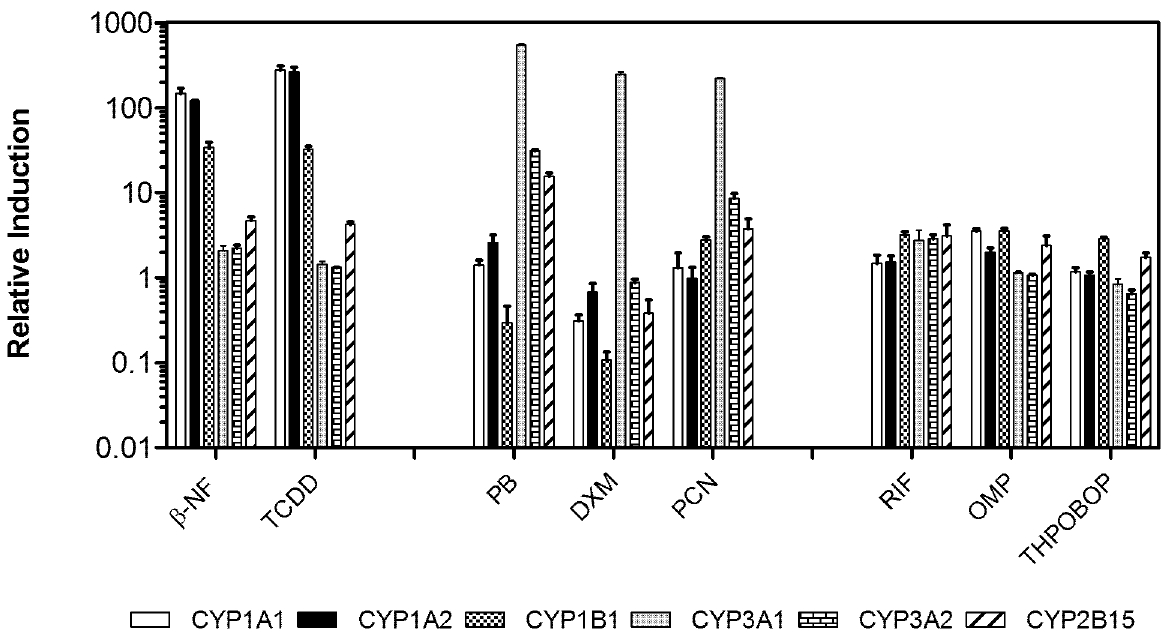
Fig 1. Comparison of CYP gene expression by the prototypical inducers in rat hepatocytes. Data are reported as means ± SD (standard deviation).